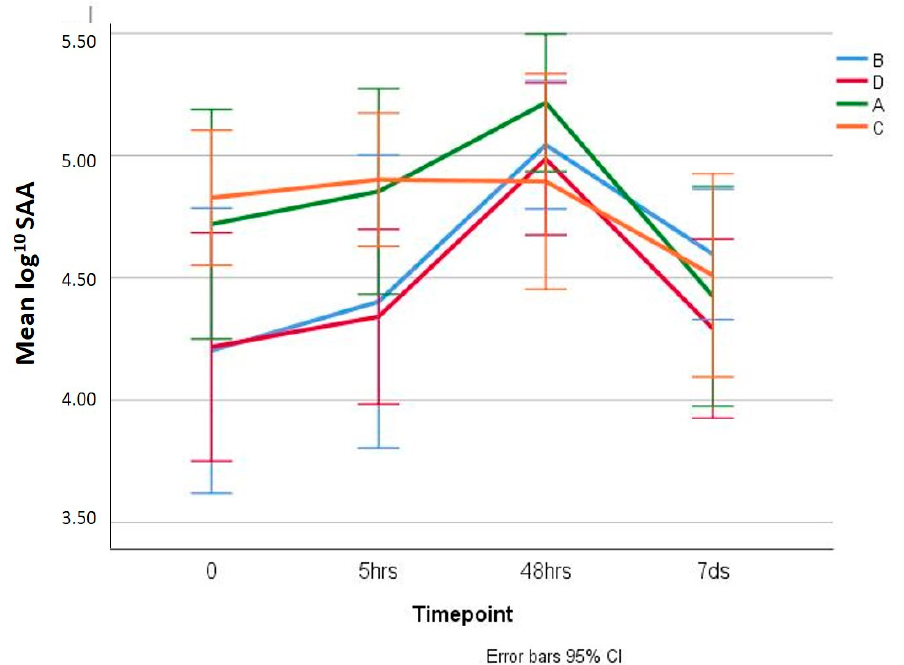
Figure 3. Mean of log 10 SAA in the four Groups A, B, C, and D, prior to tail docking (S0), and at 5 h (S1) and 48 h (S2) intervals, plus seven days later (S3) (Error bar: 95% CI). Groups A and C, the tail was excised with a scalpel without anaesthesia or stitches; Groups B and D, the tail was surgically excised and stitched under GA; with Groups C and D immediately sprayed with PR.